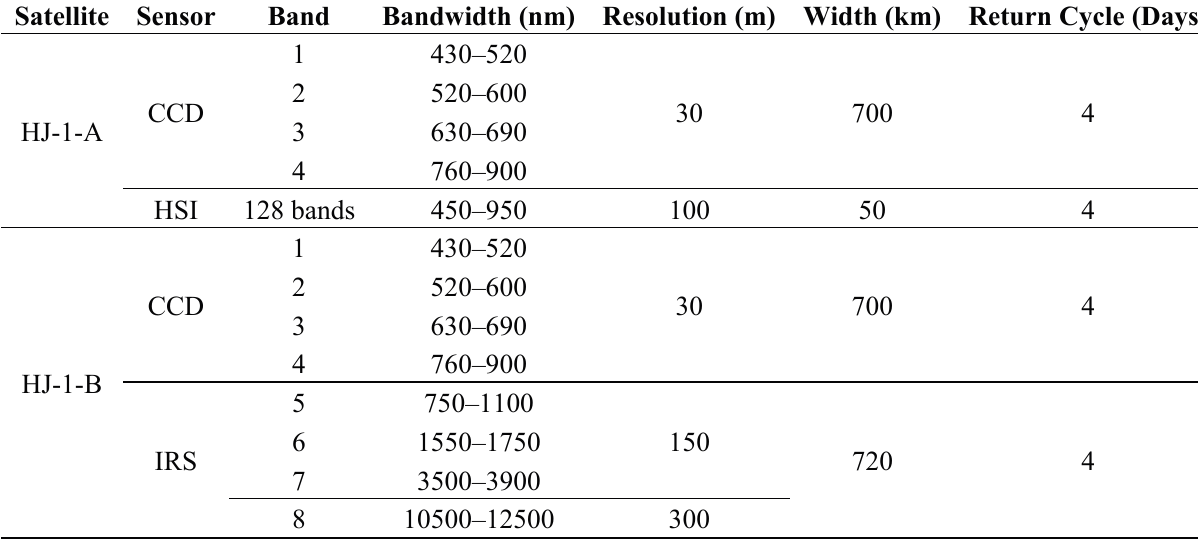
Table 2. Parameters for HJ satellite constellation sensors.